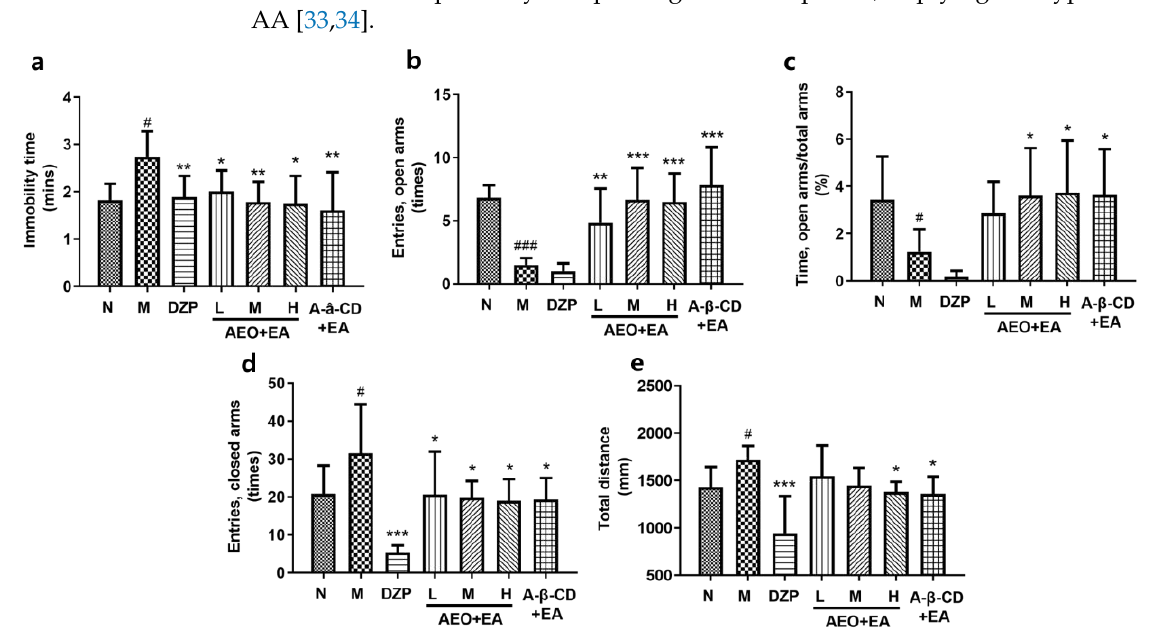
Figure 8. Effects of the tail suspension test and elevated cross maze test. ( a ) The effect on the immobility time in the tail suspension test, ( b ) the number of rats entering the open arms, ( c ) the ratio of the time between entering the open arms and the total arms, ( d ) the number of rats entering the closed arms, ( e ) the total distance into the maze. The level of significance was set at # p < 0.05, ### p < 0.001, compared to the normal group; * p < 0.05, ** p < 0.01 and *** p < 0.001 compared to the model group. Data were presented as mean ± SD ( n = 6).